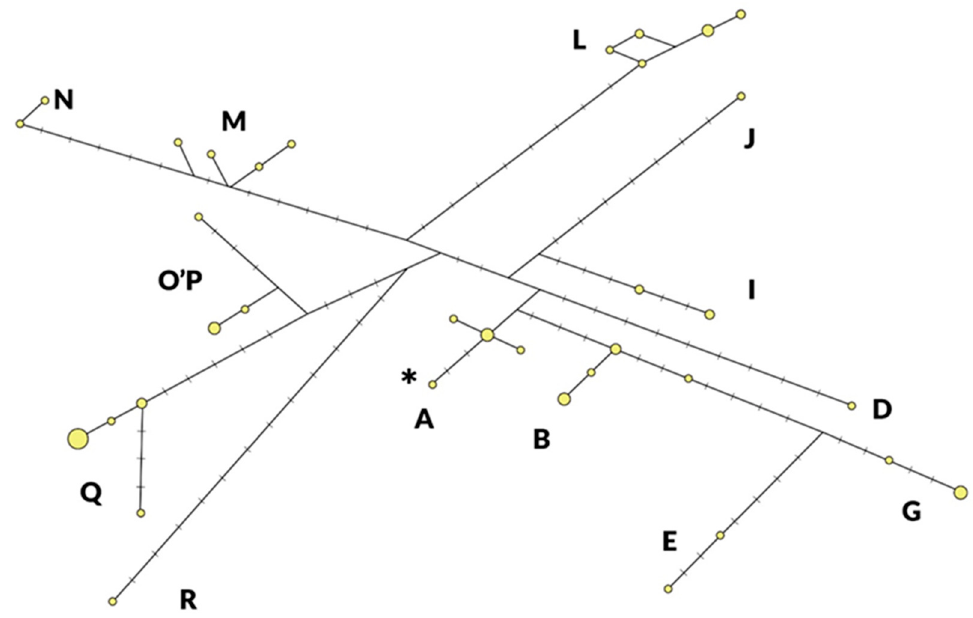
Figure 1. Distribution of haplogroups (A–R) and haplotypes (yellow circles) detected in Szekler horse ( n = 59). The size of the circles is in proportion to the number of individuals observed per haplotype. The lines crossed in the sections connecting the haplotypes indicate the number of mutations between them. The asterisk indicates the haplotype identical to Equine Reference Sequence, NC001640, published in GenBank. Table 1. Haplogroup frequencies of Szekler horse compared with the former results.